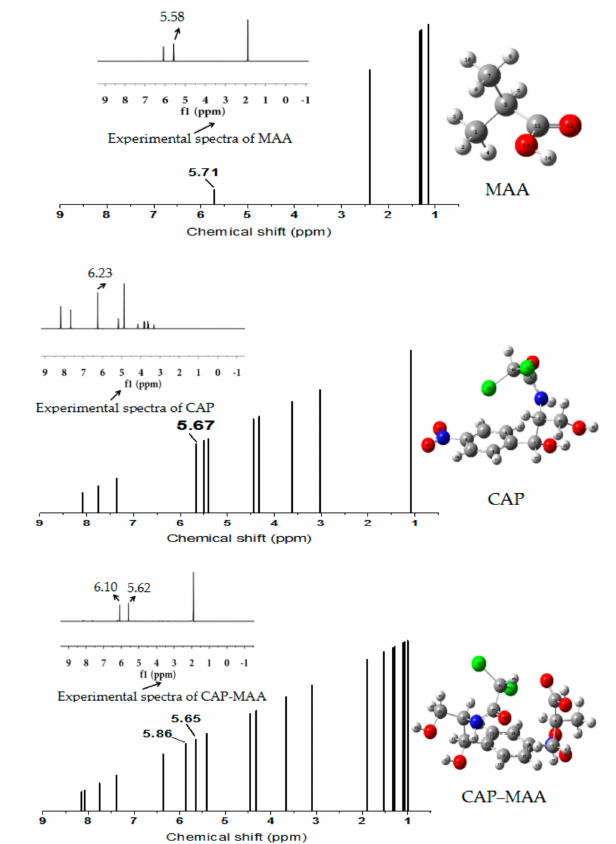
Figure 8. Theoretical and experimental 1 H-NMR spectra of MAA, template CAP, and the CAP–MAA